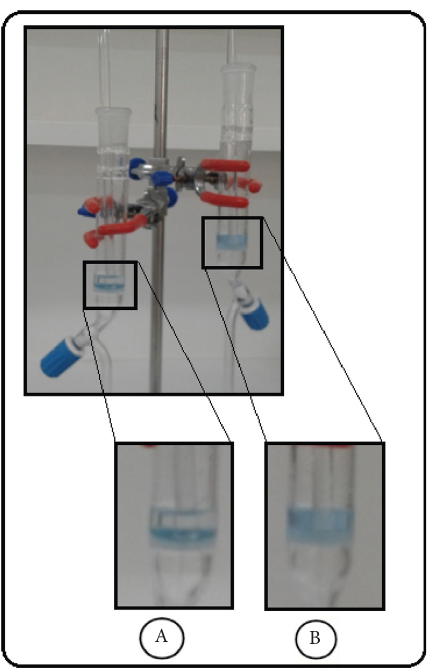
Figure 5: Dye-peptide binding test: Once the support is ready, a contact with the peptide in the basic medium allows their binding by means of disulfide bond formation between the cysteine of the support and the cysteine of the peptide. A solution of “Cibacron blue” at a concentration of 10mg/L for 48h is then contacted with the support-bound peptide, and finally, the OD of the filtrate is